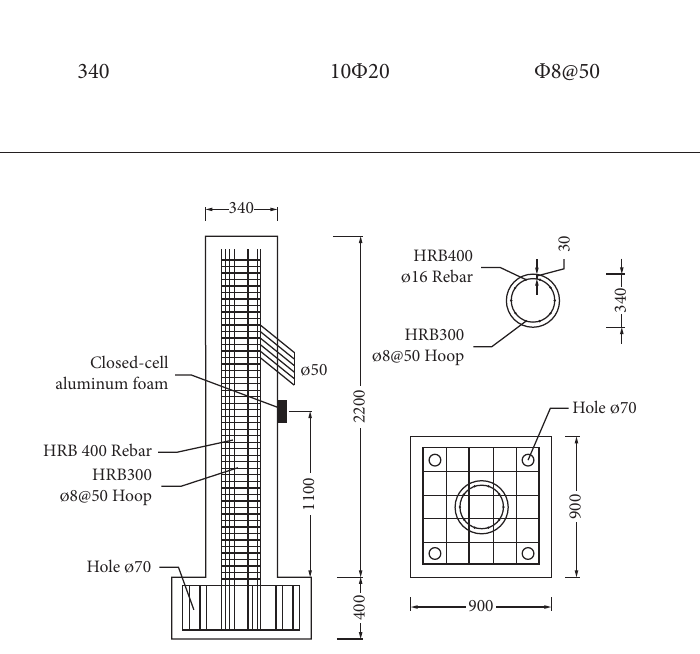
Figure 2: Reinforcement schematics of the specimens (unit: mm). Table 2: Properties of the reinforcement material.